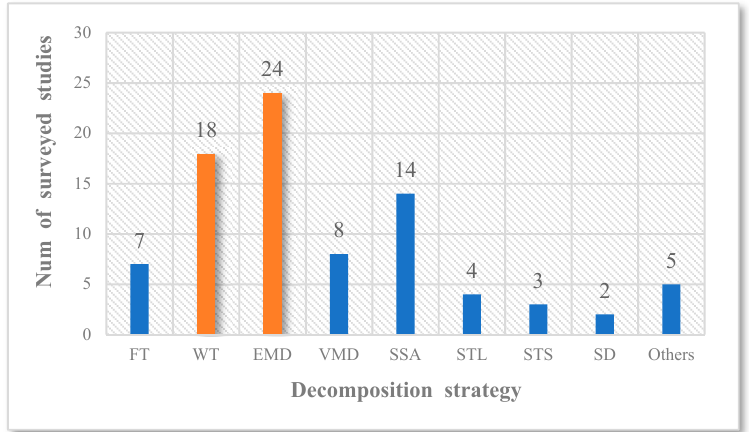
Figure 2. Statistics of decomposition strategies.